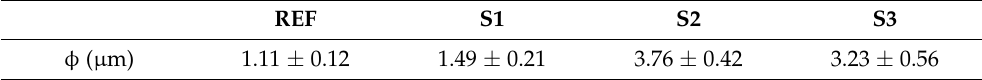
Table 2. Variation in fiber diameters of the different samples